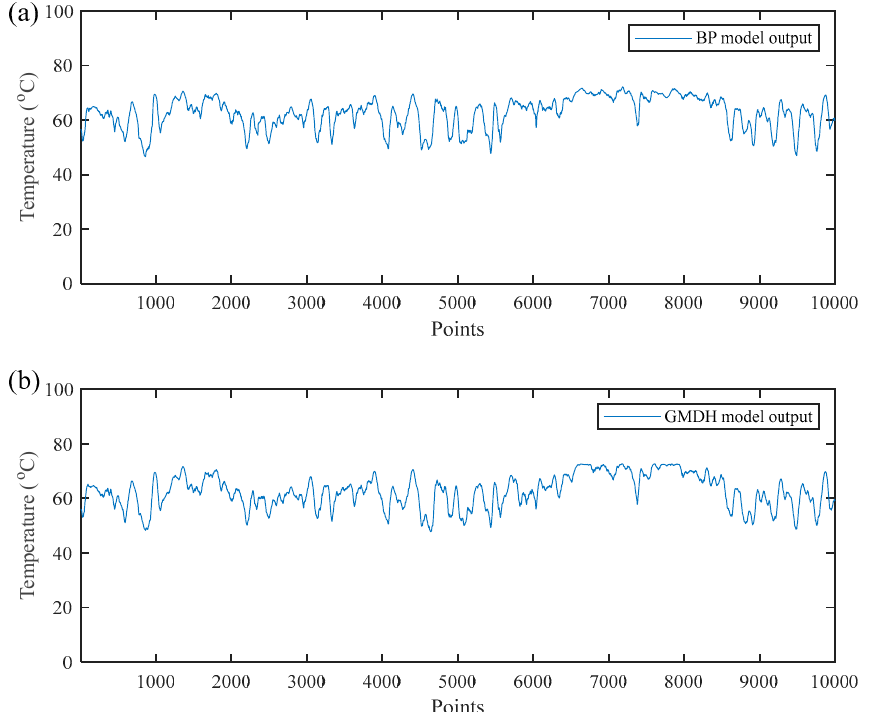
Figure 16. Predicted temperature of the gearbox bearing gained from the GMDH model. ( a ) BP model output, ( b ) GMDH model output.